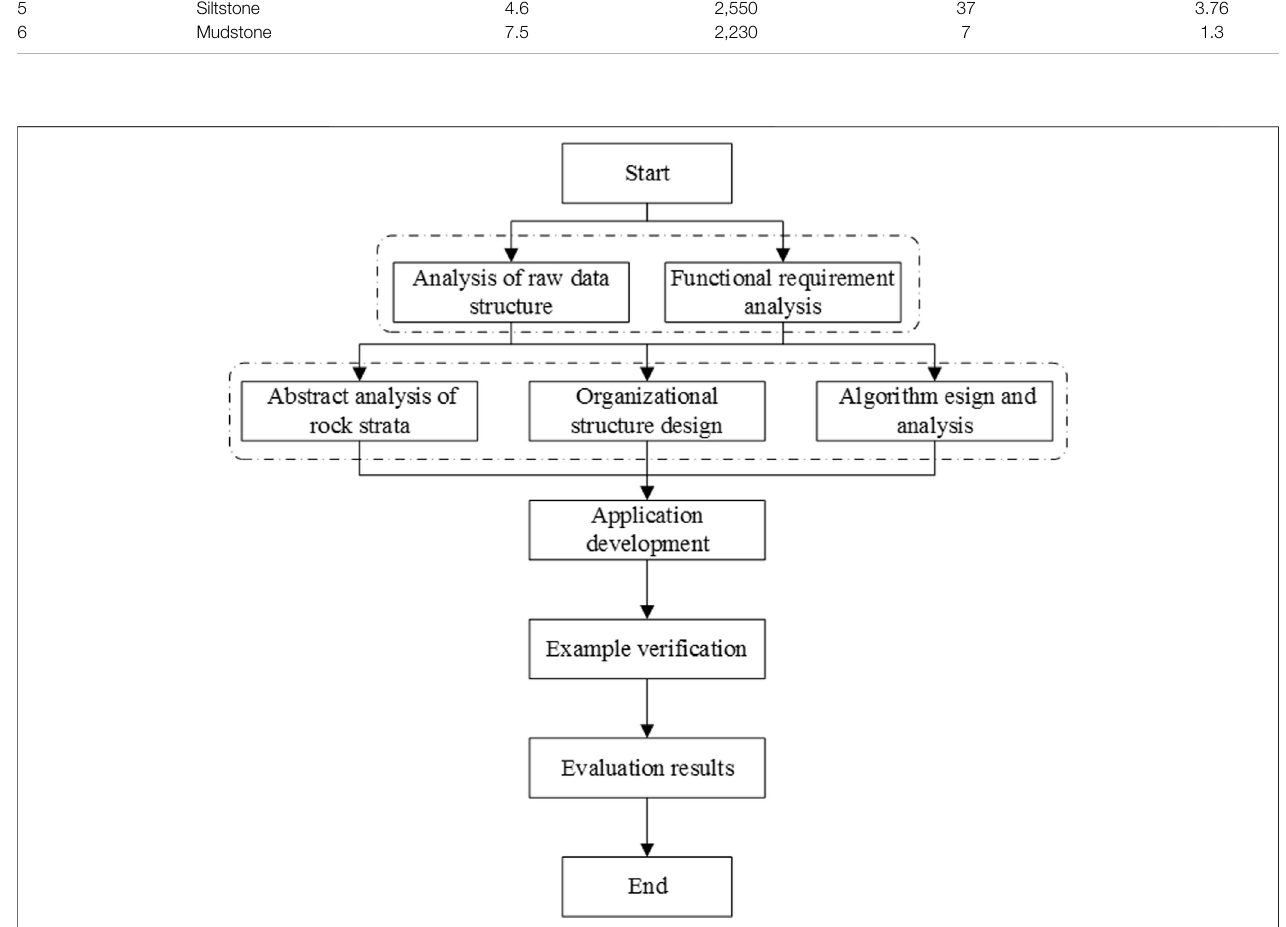
FIGURE 2 | Research framework of KS calculation